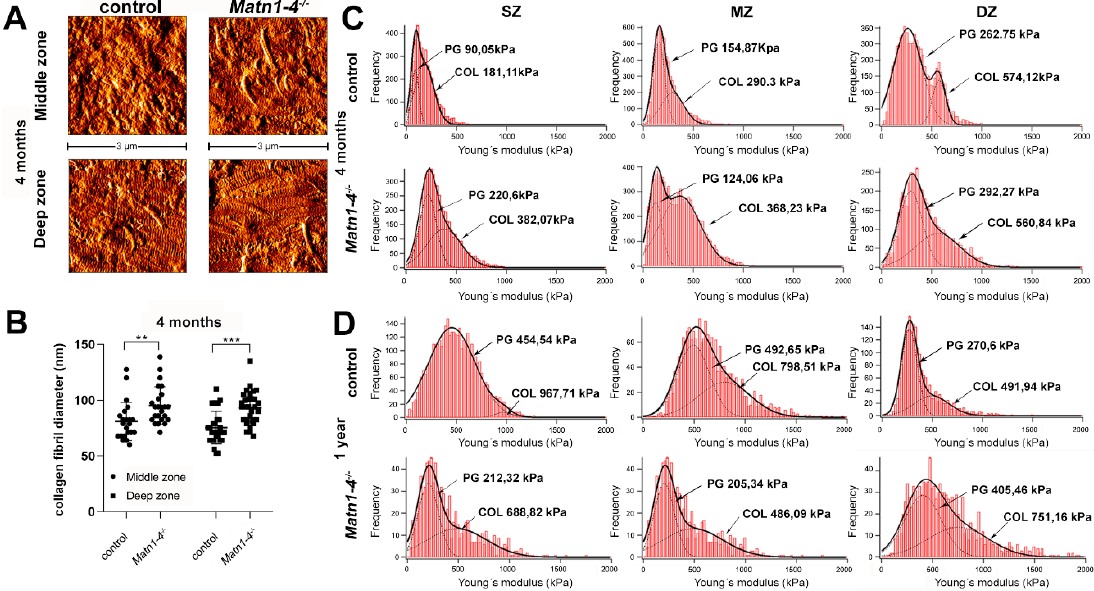
Figure 8. Altered biomechanical properties of articular cartilage in Matn1-4 − / − mice. High resolution AFM images of articular cartilage at 4 months ( A ) showed comparable organization of the collagenous networks in control and mutant. ( B ) Significant thickening of the collagen fibrils was detected in the middle (** p < 0.01) and the deep zones (*** p < 0.001) of the articular cartilage of Matn1-4 − / − mice. ( C ) Nanoindentation AFM demonstrated stiffer mutant matrix in the superficial zone (SZ) at four months. ( D ) At 1 year, softer ECM was detected in the superficial and middle (MZ) zones, whereas a stiffer matrix was observed in the deep zone (DZ) of the Matn1-4 − / − mice. On each histogram, the solid line represents the sum of two Gaussian functions, whereas the dashed lines indicate individual fits representing proteoglycans (first peak, PG) and the collagen fibrils (second peak,